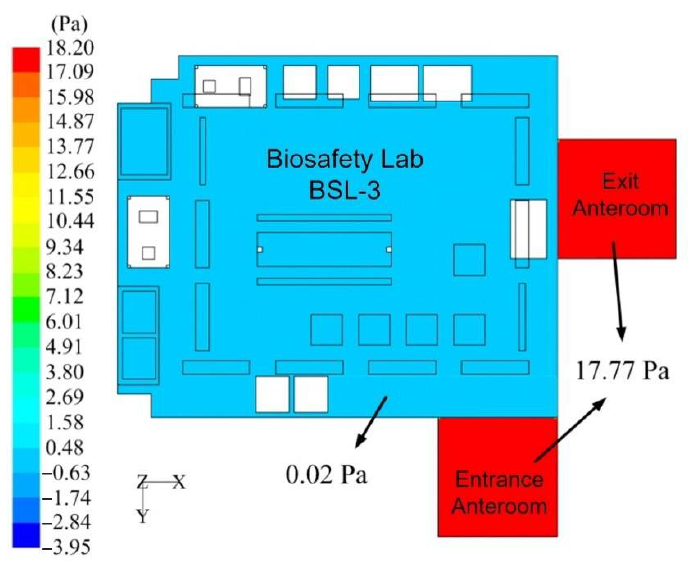
Figure 8. The pressure difference between biosafety lab and anteroom.